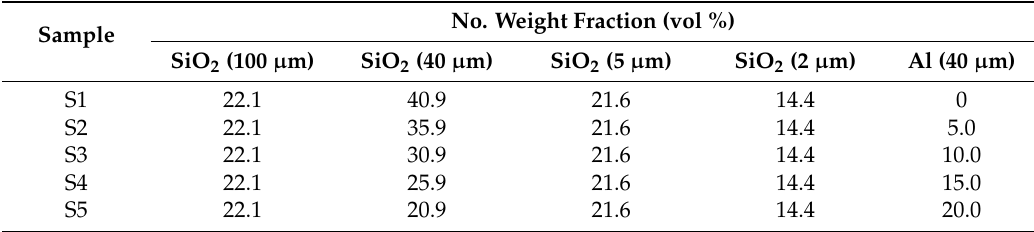
Table 1. Compositions of gelcasting SiO 2 -based samples.